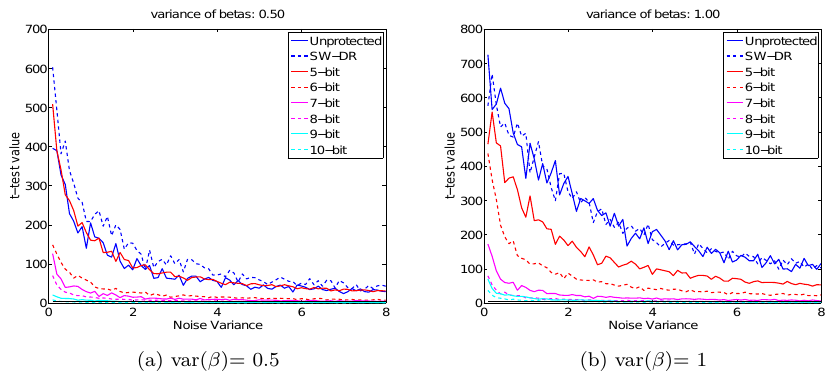
Figure 1: TVLA results for unprotected and countermeasure (5 to 10 bits encoding and software dual-rail (SW-DR)) with different β